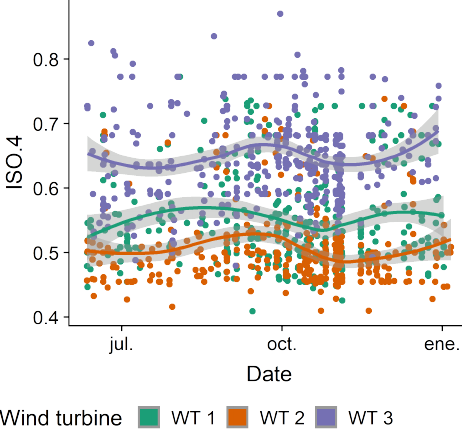
Figure 11. RMS values of ISO.14 variable and smoothed trend fitted with LOESS.